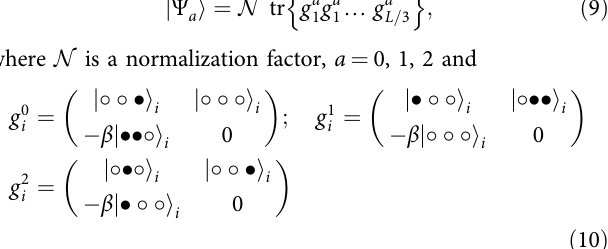
Fig. 3 Characteristics of the DDS basis states. a Expectation value Tr ð ρ ^ n x Þ for different positions x . Starting from a CDW con fi guration, the system is evolved using a protocol with a given β . This generates a DDS state that i , etc. The dark space basis depends on β . The top row represents the pure state ϱ 00 = 1, while the i second row represents the mixed state ϱ 00 = 0.5, ϱ 11 = 0.3, ϱ 22 = 0.2. Different colors are used to help track the changes in average occupation at each site and to highlight the 3-site periodicity of the density. b Static structure factor S 1 ( k ) for different values of β , for a pure state with ρ 11 = 1. At β = 0 the system is in the CDW state, with a de fi nite spatial periodicity, ; 4 π indicated by the peaks in S 1 ( k ) at k ¼ 0 ; 2 π . Increasing ∣ β ∣ , the system 3 3 becomes more homogeneous. c Entanglement entropy of the DDS as a function of β